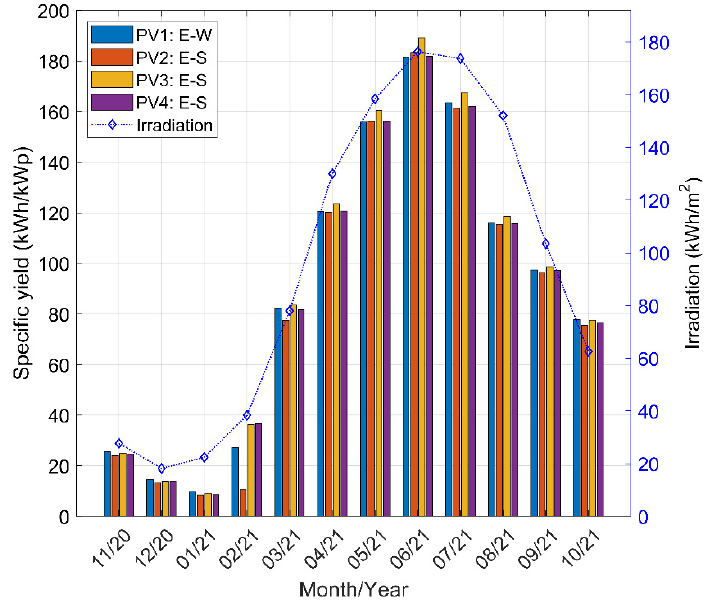
Figure 1. Monthly specific yield of PV1–PV4 rooftop systems. Irradiation was computed for 2005– 2020 using PVGIS 5.2.